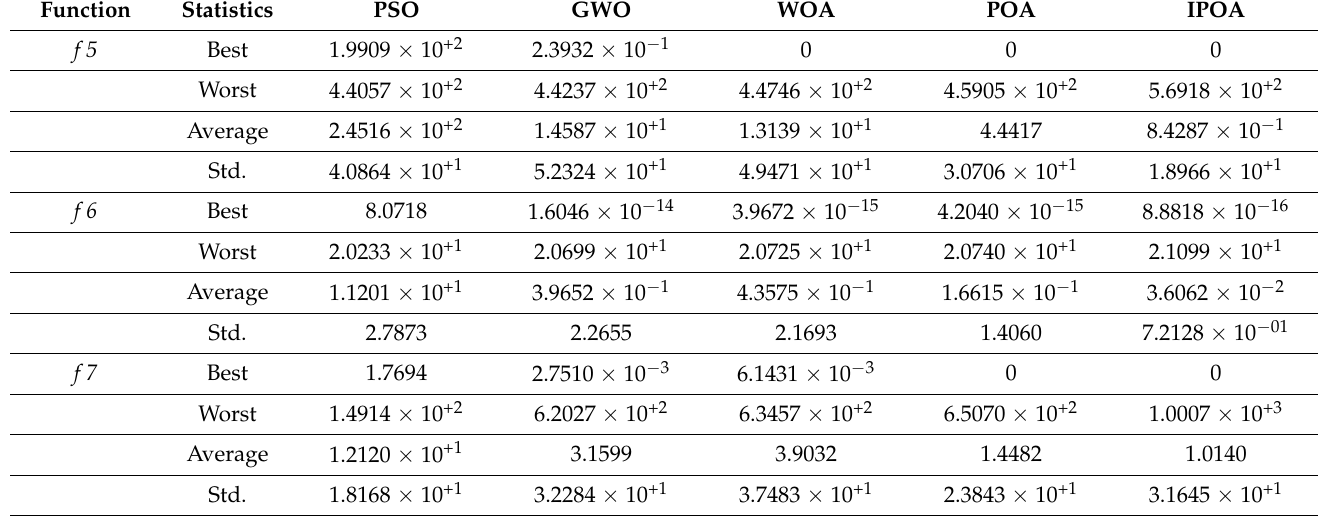
Table 4. Statistical results for multimodal benchmark functions.